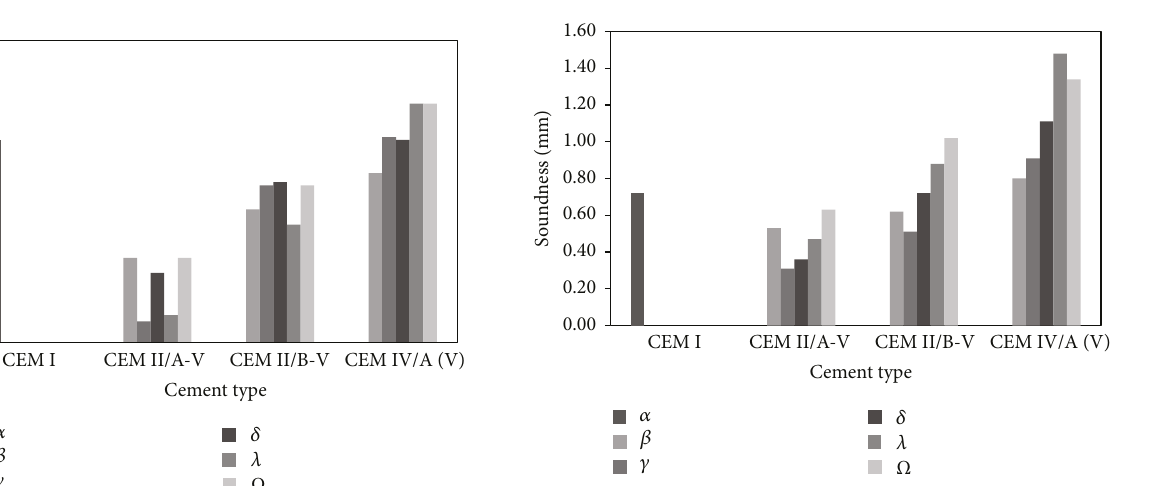
Figure 7: Water demand for normal consistency of the cement pastes.